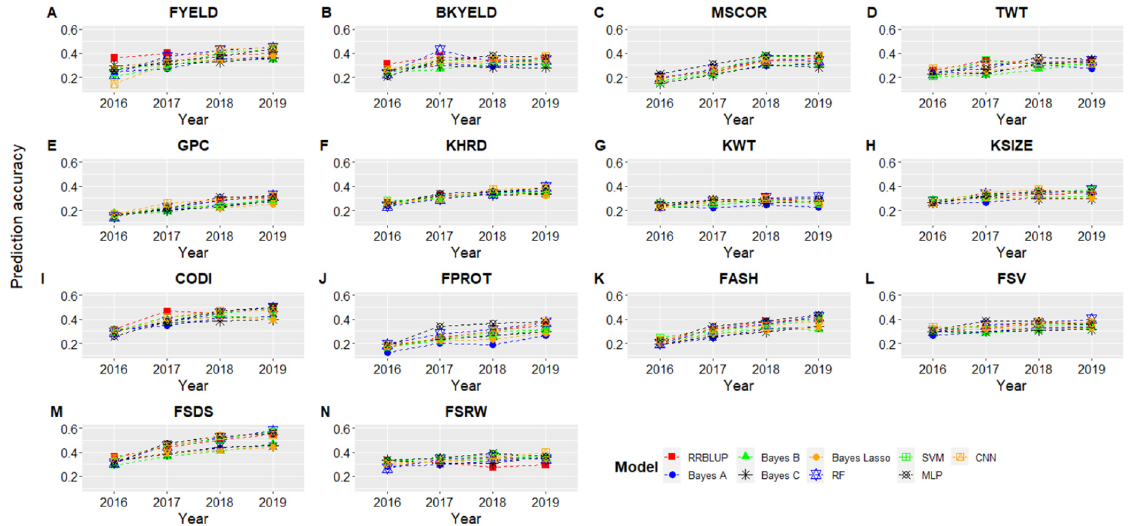
Figure 4. Genomic selection forward prediction accuracies for Lind, WA, when all datasets from previous years were included to predict fourteen end-use quality traits using nine different models. The x -axis represents the year for which predictions were made using previous years as the training set. All abbreviations are previously abbreviated in the text and Table